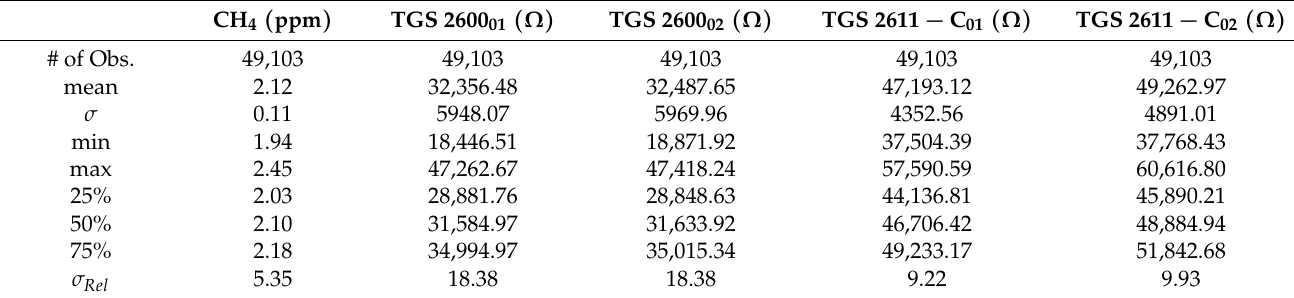
Table 1. Summary of the statistics for each variable in the